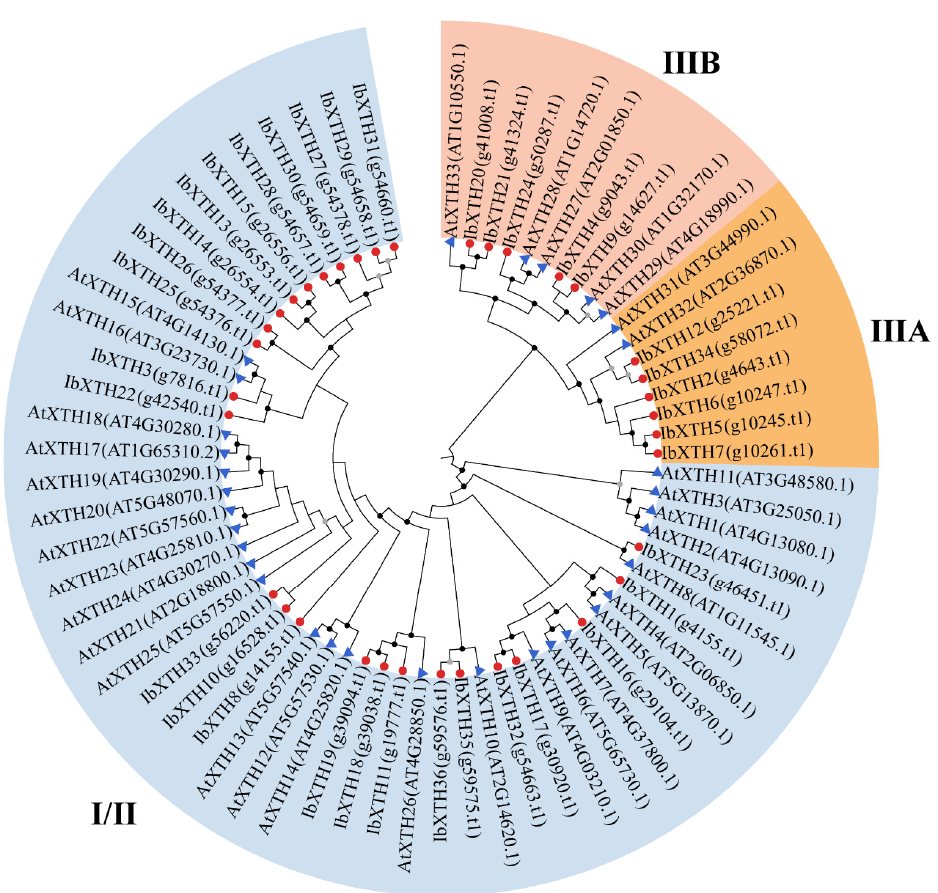
Figure 2. Neighbor-Joining phylogenetic tree analysis of XTH proteins from sweet potato and Arabidopsis constructed by MEGA 7.0 with the default parameters. The evolutionary tree was divided into three subfamilies with different colors. According to the previous subfamily classification of Arabidopsis XTH proteins, in which AtXTH1 -AtXTH26 belong to subgroup I/II, AtXTH31 and AtXTH32 belong to subgroup III-A, and the rest of the proteins belong to subgroup III-B, sweet potato XTH proteins were classified into three subfamilies, namely I / II (blue), IIIA (yellow), and III B (pink). The blue triangle represents Arabidopsis XTH proteins, while the red circle represents sweet potato XTH proteins. Among the 36 IbXTH s in sweet potato, the shortest (IbXTH 13 ) was of 164 aa, while the longest (IbXTH 8 ) was of 344 aa, and the average length of genes was 280.22 amino acids. The predicted MWs of the Ib XTH were as high as 38.73763kDa (IbXTH8) and as low as 3.30876 kDa (IbXTH17). The pI (isoelectric point) values of 21 out of 36 XTH in I. batatas were higher than 7.0, indicating that most of the sweet potato XTHs were alkaline pro- teins. The pI value of Ib XTH04was only 4.69, whereas the pI value of IbXTH21 as the